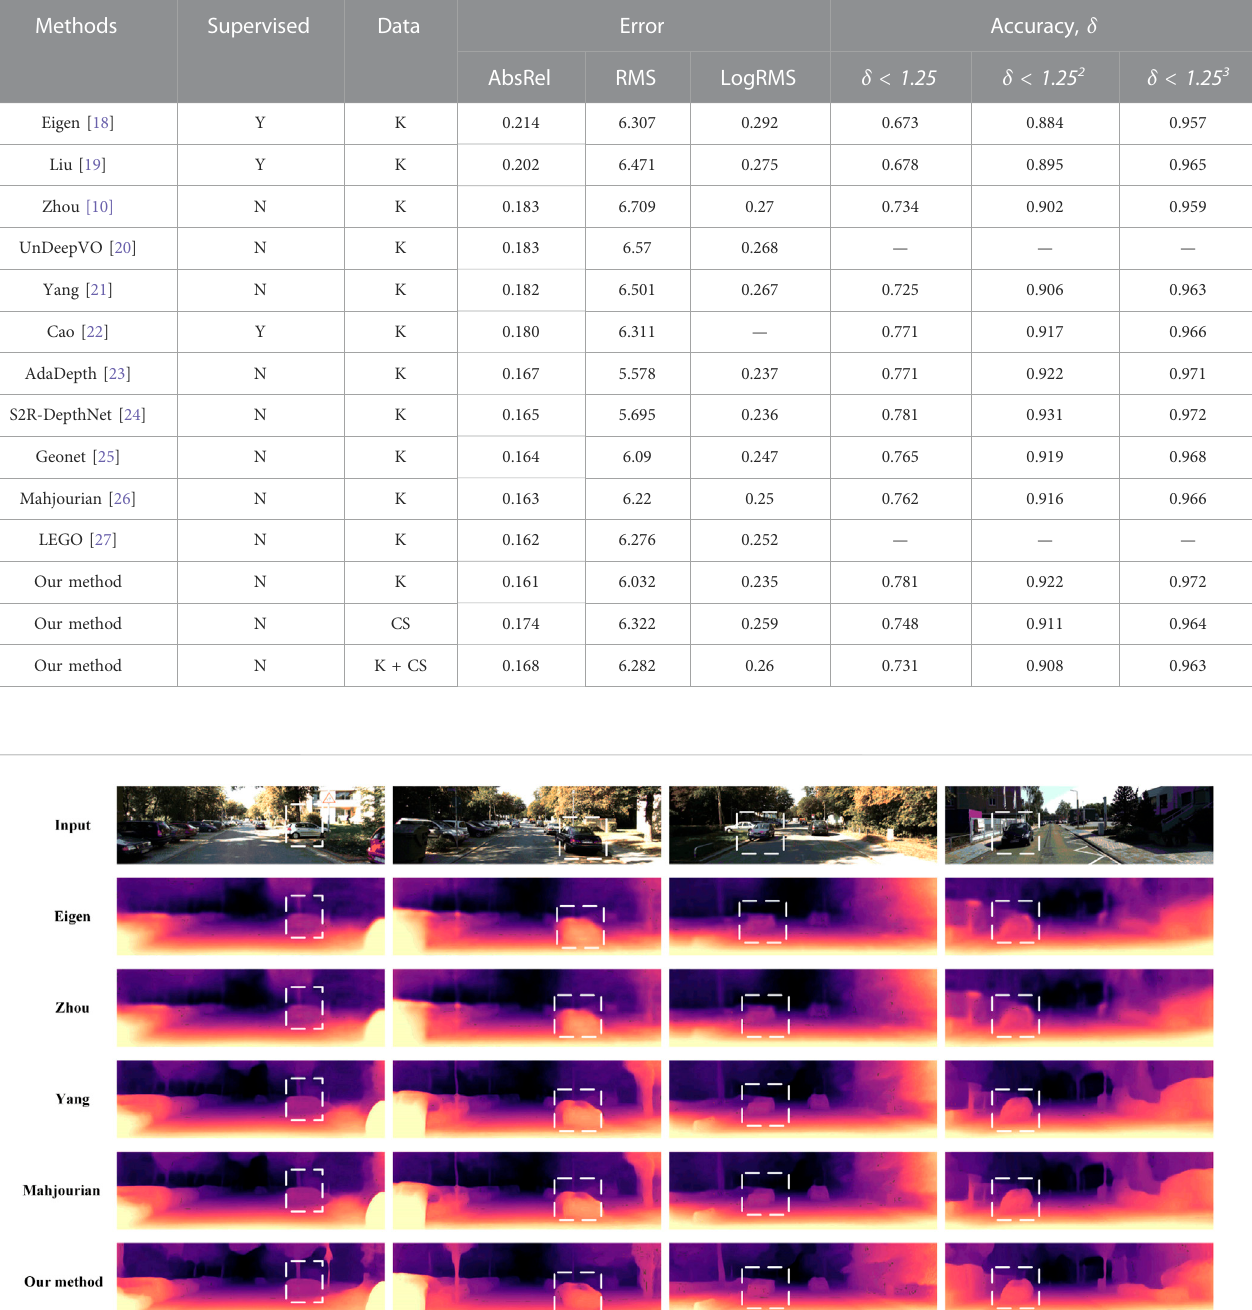
TABLE 3 Comparison of experimental results with other related research algorithms.